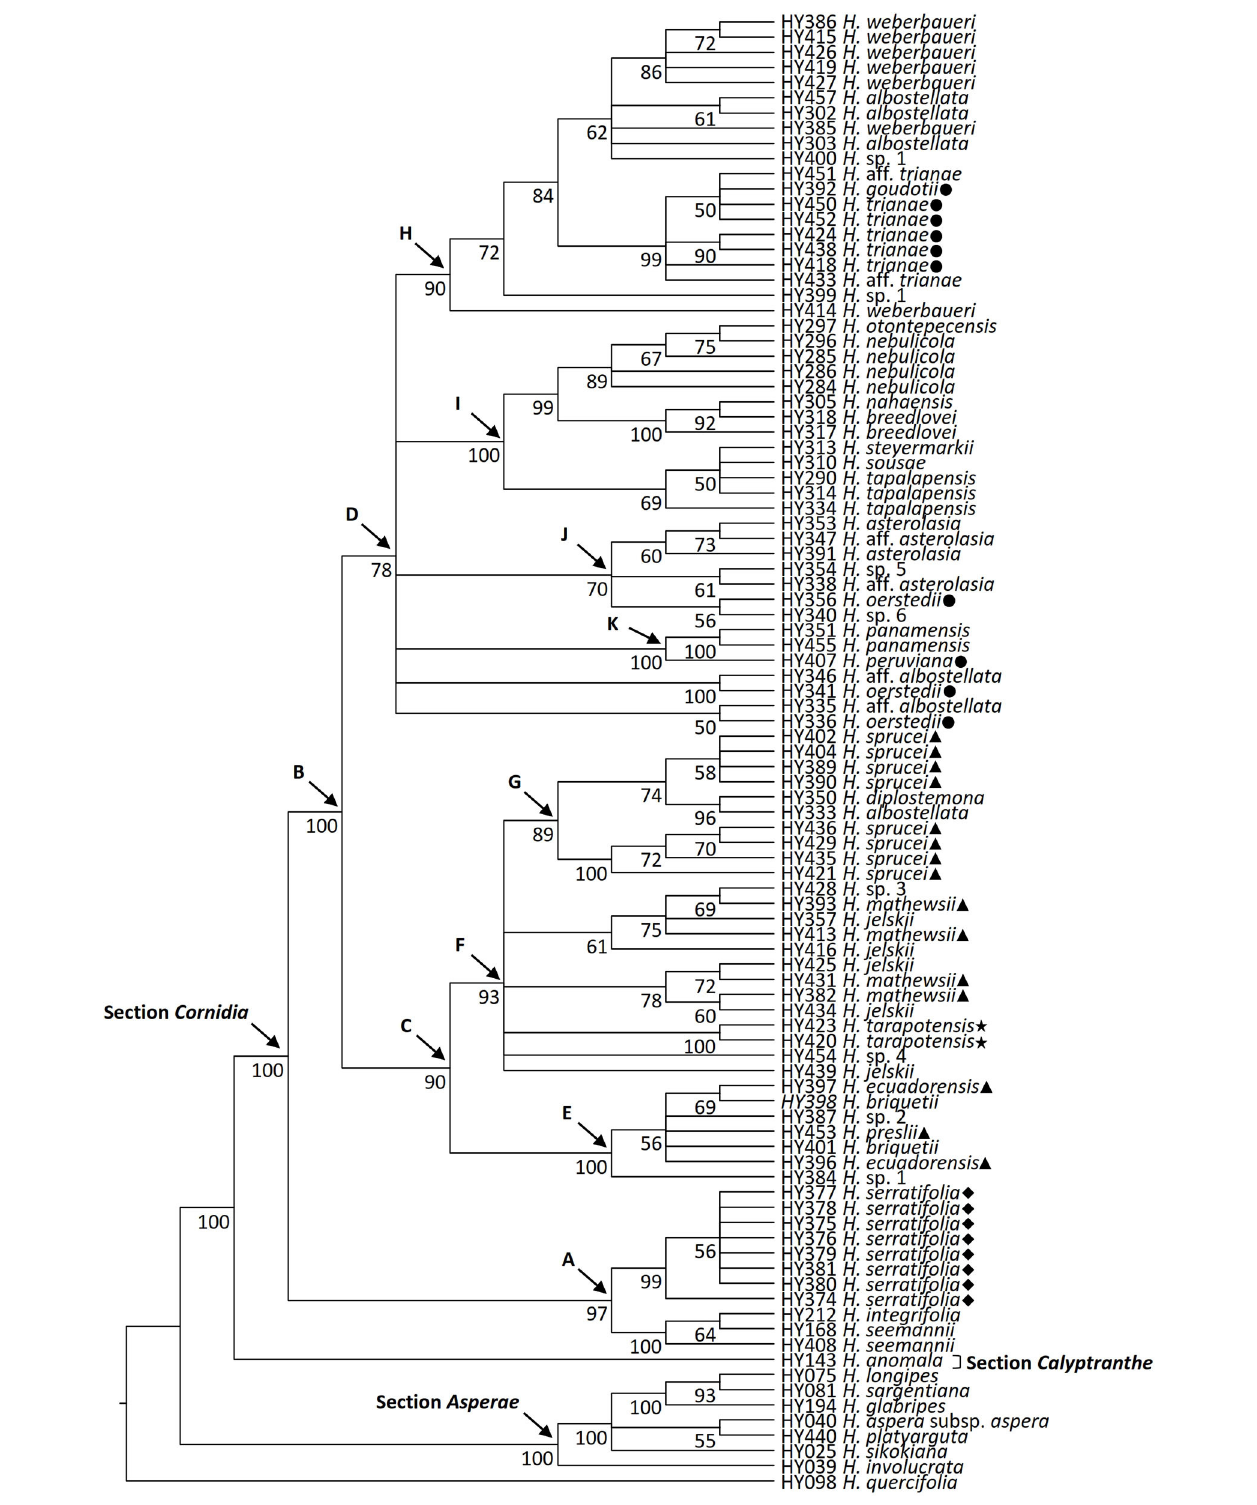
FIGURE 2 | Phylogenetic relationships of Hydrangea section Cornidia based on the combined analysis of the SMC1 and TIF3H1 low-copy nuclear genes DNA sequences. Bootstrap values ≥ 50% are shown below the branches. Current sectional classification ( sensu De Smet et al., 2015) is denoted in boldface. Shapes in front of species names indicate Briquet’s (1919) infrasectional classification as follows: subsection Monosegia series Speciosae (circle), subsection Monosegia series Aphananthae (triangle), subsection Polysegia series Synstyleae (star), and subsection Polysegia series Chorystyleae (diamond). A–K denote main clades discussed in the